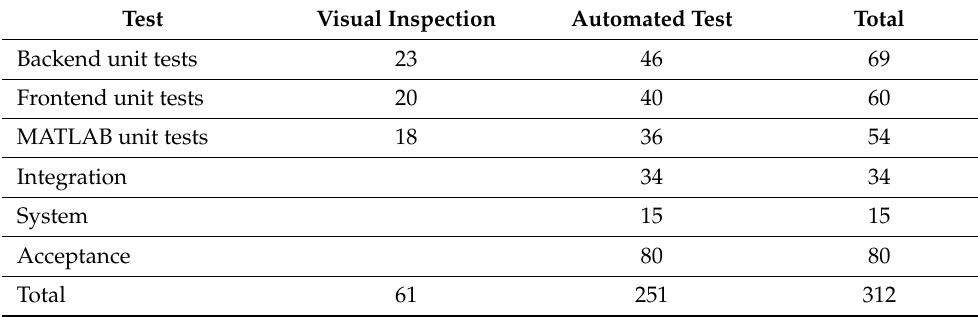
Table 1. Types of testing carried out on the web application. Test Visual Inspection Automated